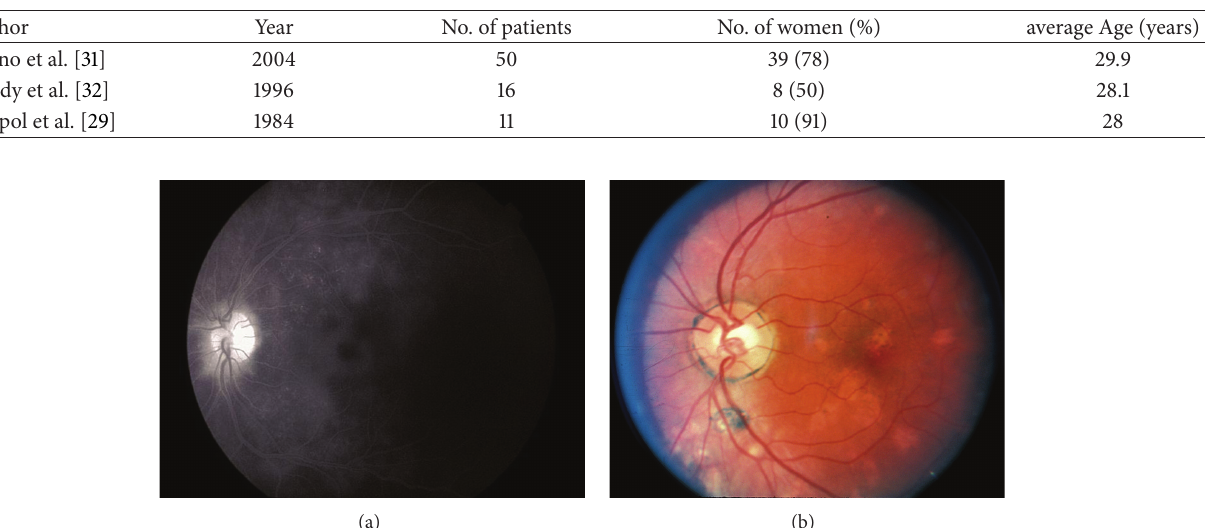
Table 3: Reports for multiple evanescent white dot syndrome.